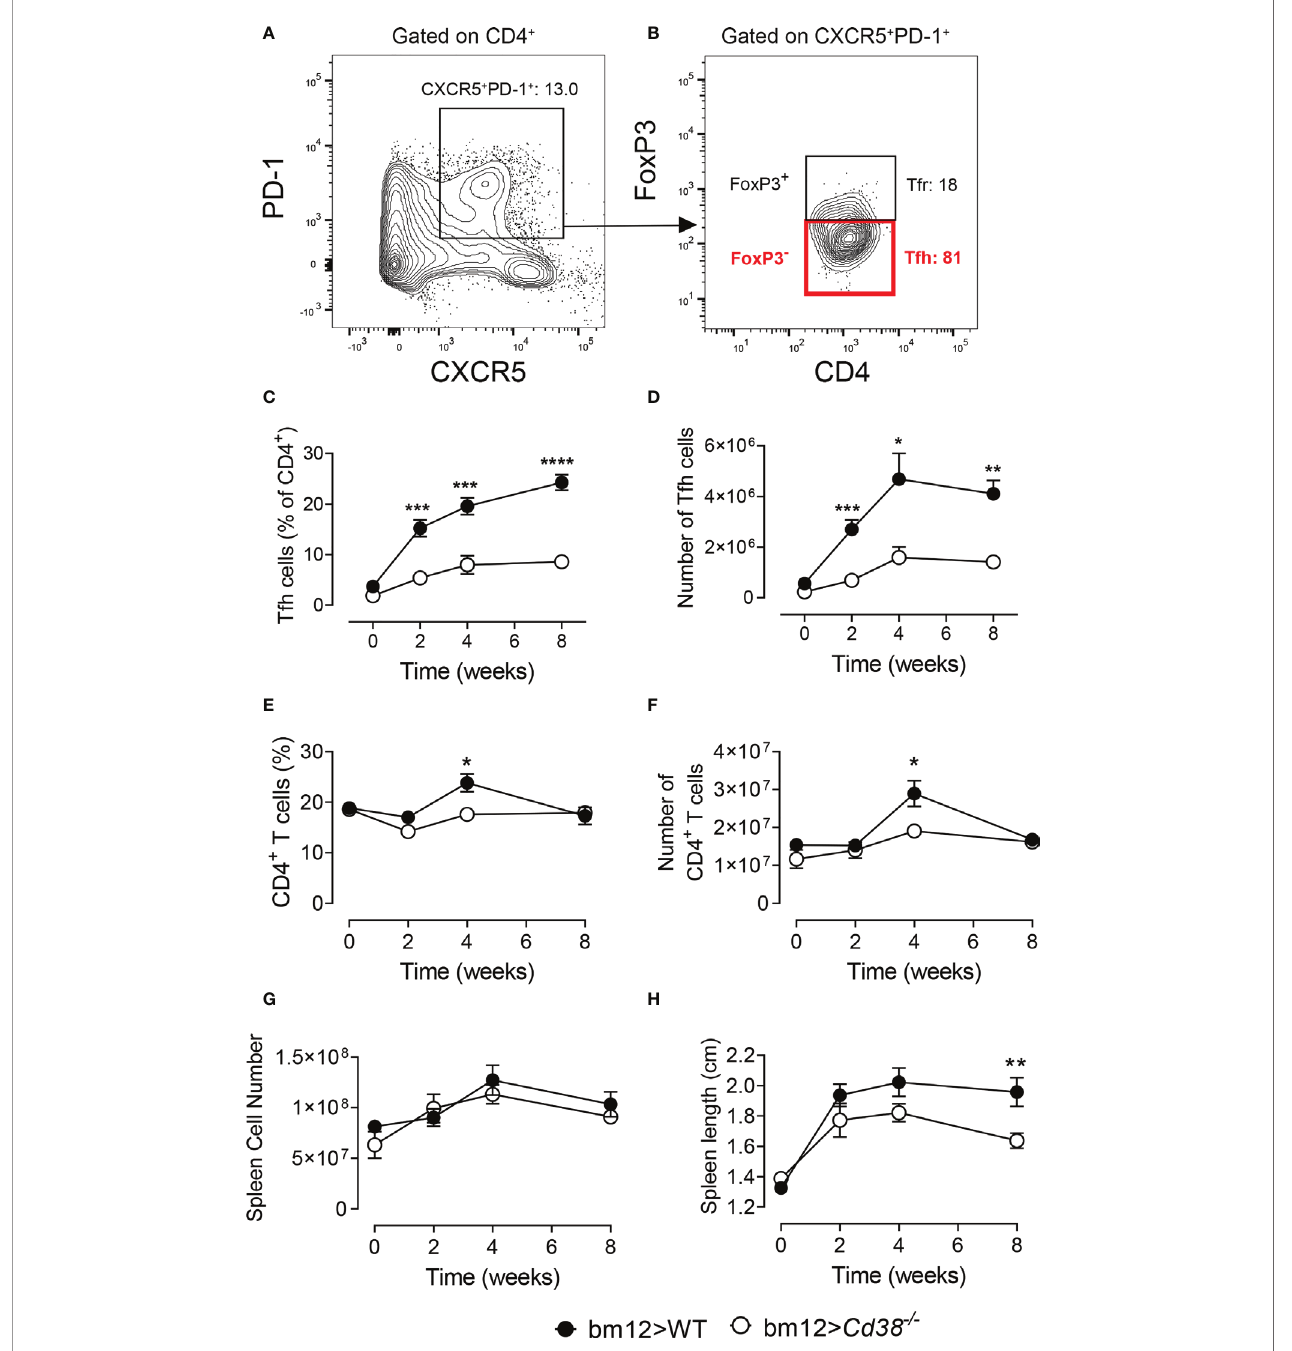
FIGURE 1 | Long-term decreased frequencies and numbers of T follicular helper (Tfh) cells in Cd38 − / − mice after adoptive transfer of bm12 spleen cells. WT mice (closed circles) or Cd38 − / − mice (open circles) were i.p. injected with bm12 cells and euthanized at the indicated time points and spleens were analyzed. (A, B) Representative fl ow cytometry contour plots showing gating strategy for Tfh cells. (A) First, gating on CD4 + cells, then gating on CXCR5 + PD-1 + . (B) Then, gating on FoxP3 − cells: CD4 + PD-1 hi CXCR5 + FoxP3 − . (C) Percentages of Tfh cells (of CD4 + T cells) in spleen at the indicated time points. (D) Total number of Tfh cells (in spleen) over time. (E) Percentages of CD4 + T cells (CD4 + TCR- b + ) in spleens. (F) Total number of CD4 + T cells in spleen. (G) Total number of spleen cells over time. (H) Spleen length (cm) over time upon the adoptive transfer. In all panels, the symbols are the mean values and the vertical bars represent ± SEM. P -values are shown for Welch ’ s t -test. The results are cumulative data from two to four different experiments per time point and mouse type, each with three to fi ve mice per experiment. * P < 0.05, ** P < 0.01, *** P < 0.001, **** P <